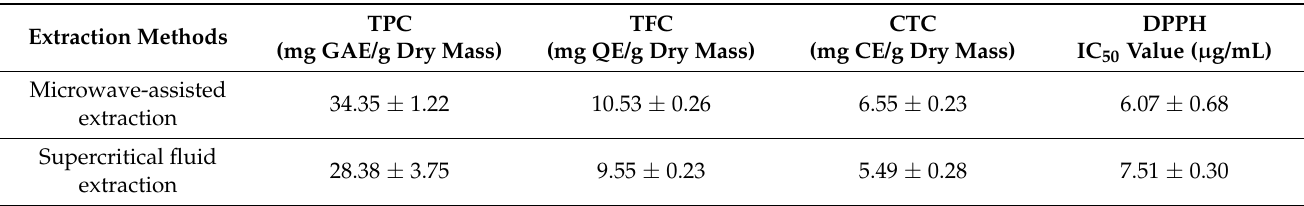
Figure 1. TPC of carob pod extracts using different extraction methods. Table 1. TPC, TFC, CTC, and antioxidant activity of carob pod